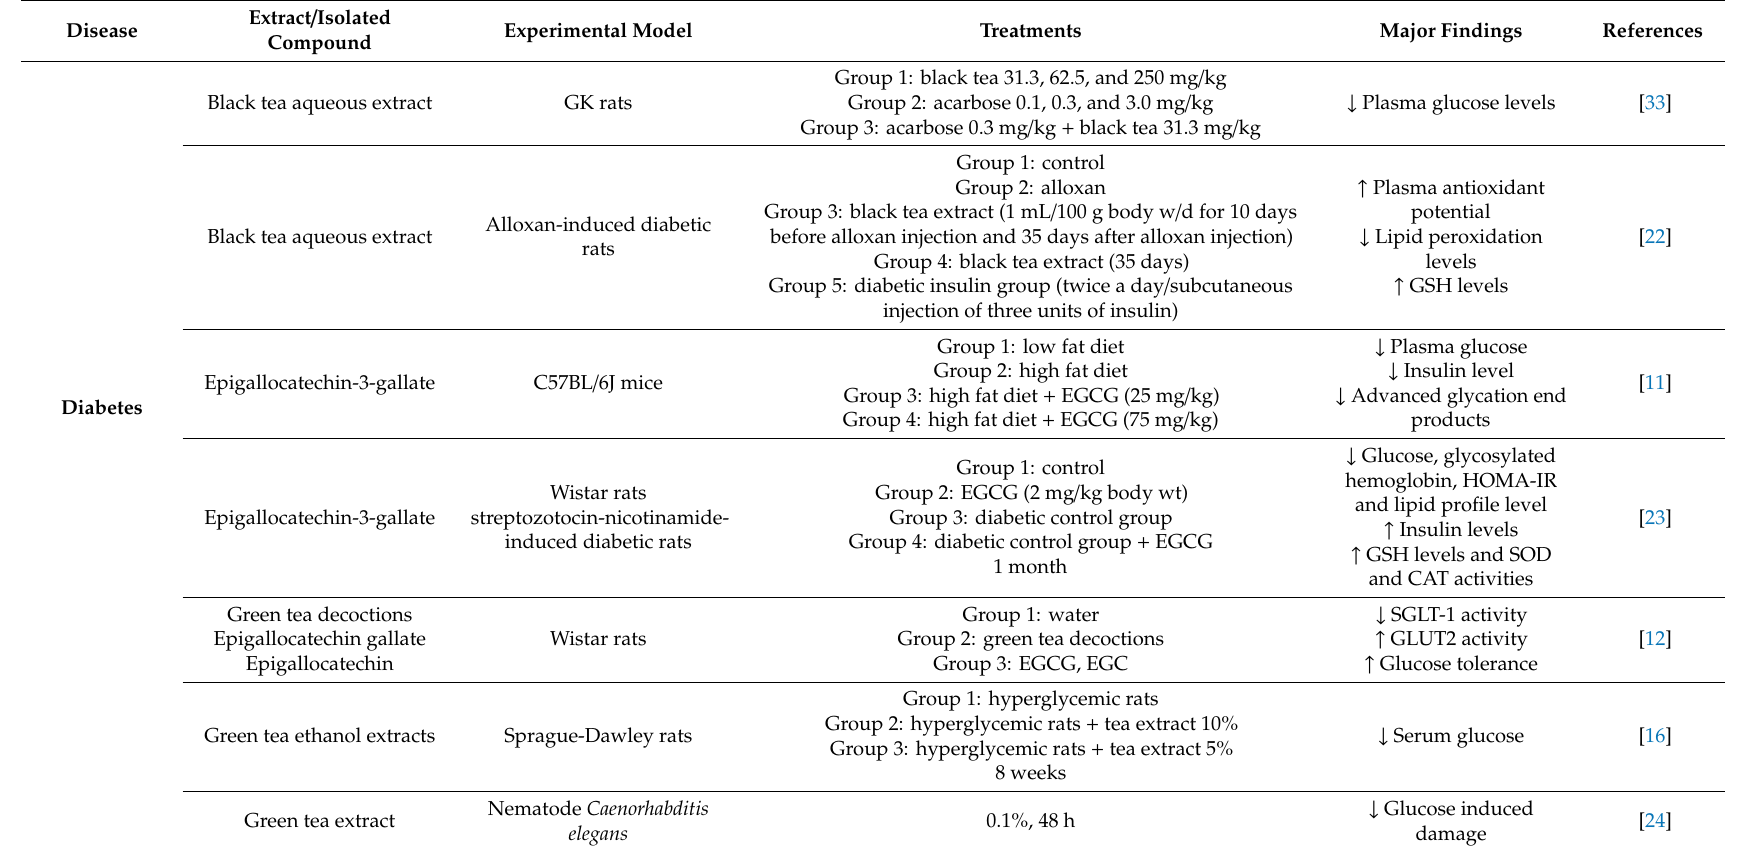
Table A2. In vivo pharmacological studies for Camellia